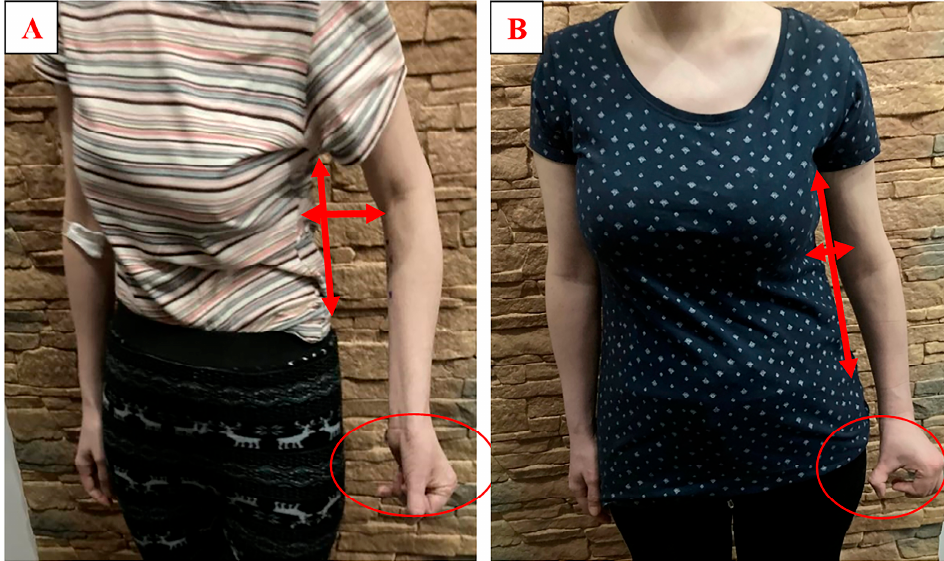
Figure 4. Patient before treatment for spasticity with botulinum toxin ( A ) and the patient after a 16-week tailored therapeutic program using the SaeboFlex ® dynamic splint combined treatment for spasticity with botulinum toxin ( B ). Vertical arrow shows the difference in the torso: shortened trunk ( A ) vs. elongated trunk ( B ). Horizontal arrow shows the distance between the trunk and the upper limb: large distance ( A ) vs. distance reduced ( B ). No side effects were observed.